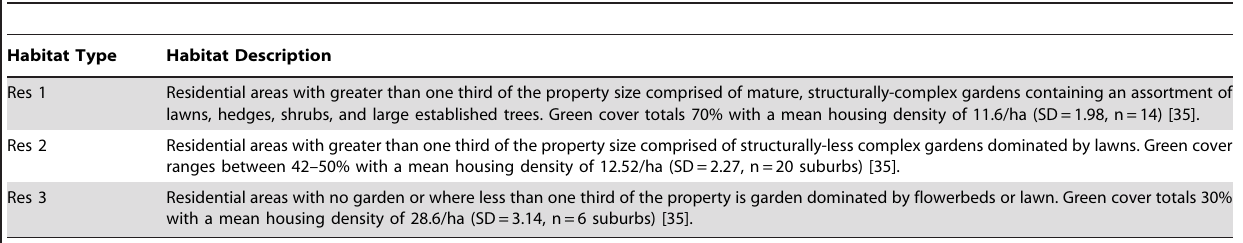
Table 1. Descriptions of the three suburban habitat types in which lightweight GPS collars were evaluated in, Dunedin, New Zealand, as defined by Freeman and Buck